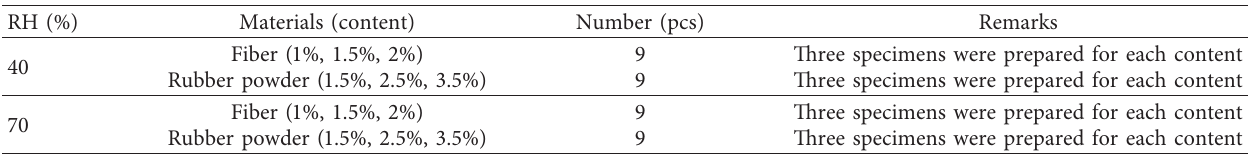
Figure 2: Experimental equipment. (a) Concrete mixer. (b) Flexural testing machine. (c) Comparator. (d) Embedded strain gauge. (e) Surface strain gauge. (f) Strain tester. Table 3: Number of